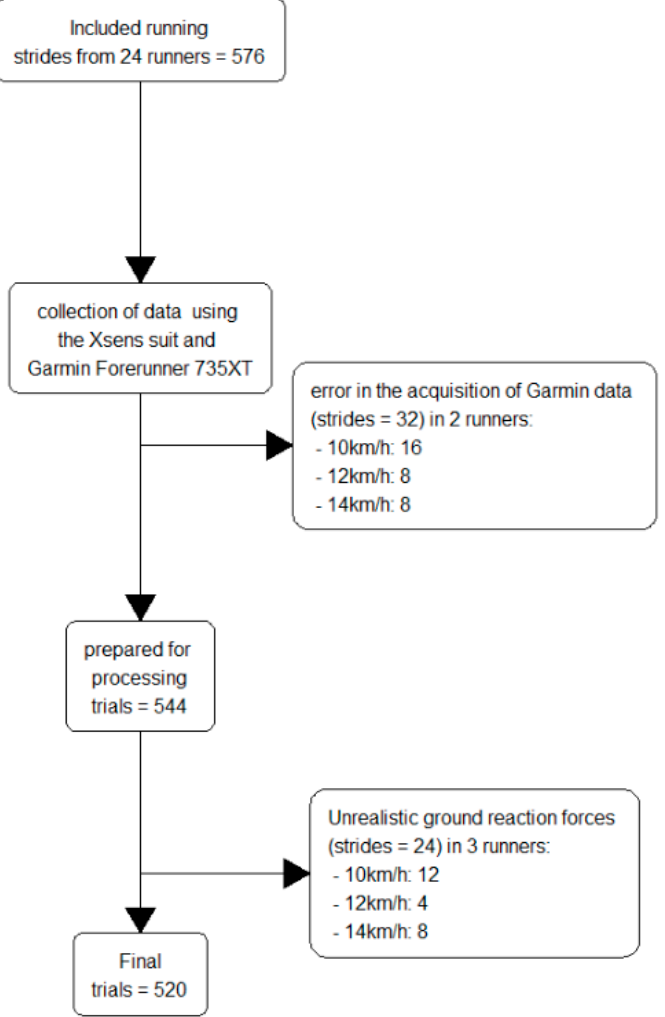
Figure 1. Flow diagram of the process from including runners to processing of data. Twenty-four runners were included for trials of 10, 12, and 14 km/h, respectively, giving 576 strides in total.